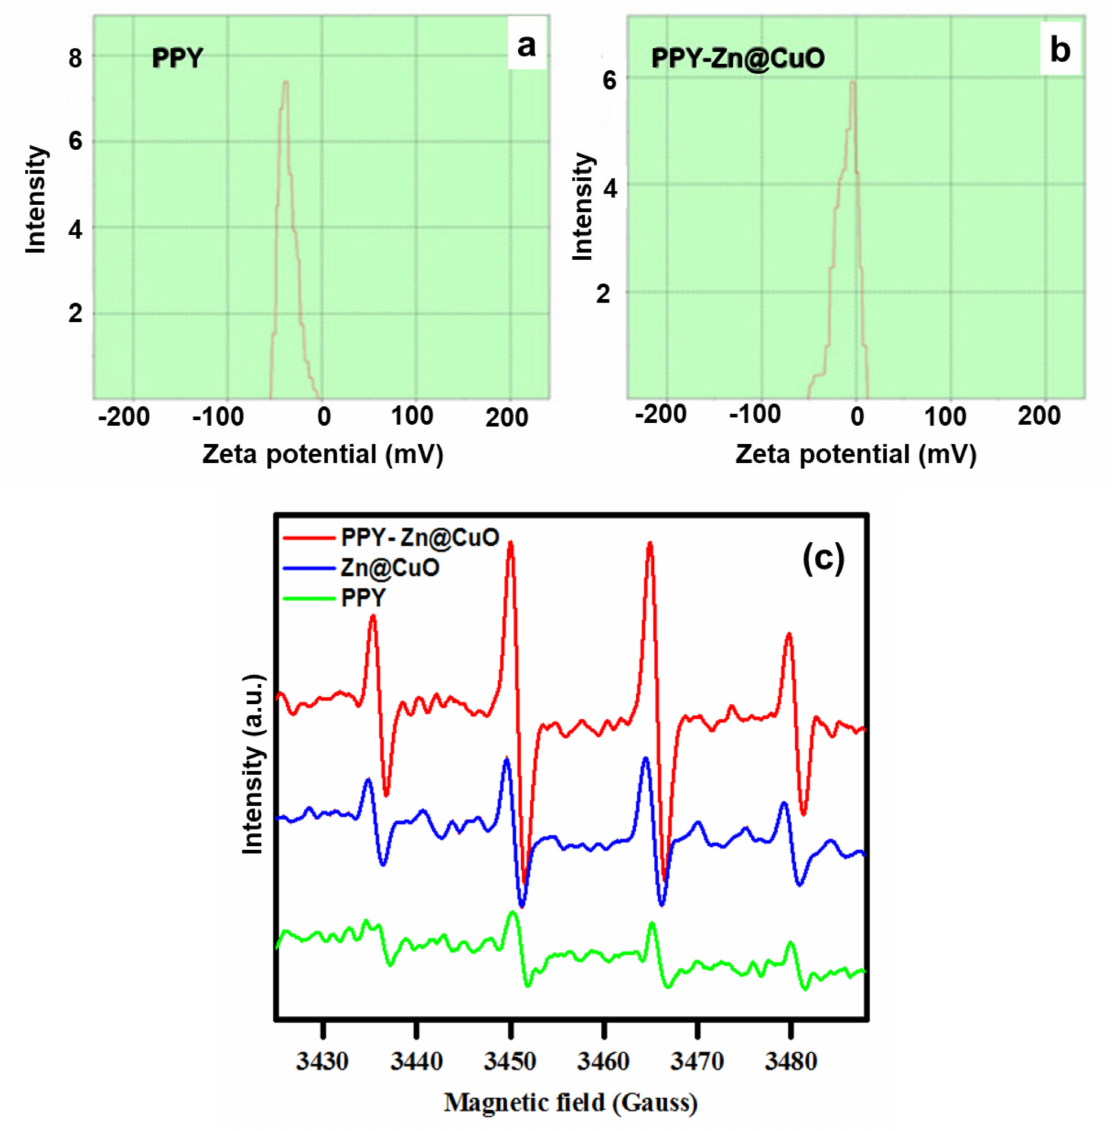
Figure 1. Zeta potentials of ( a ) PPY, and ( b )PPY − Zn@CuO ( c ) Electron paramagnetic resonance (EPR) measurement for PPY, Zn@CuO, and PPY − Zn@CuO (Reprinted from Ref.